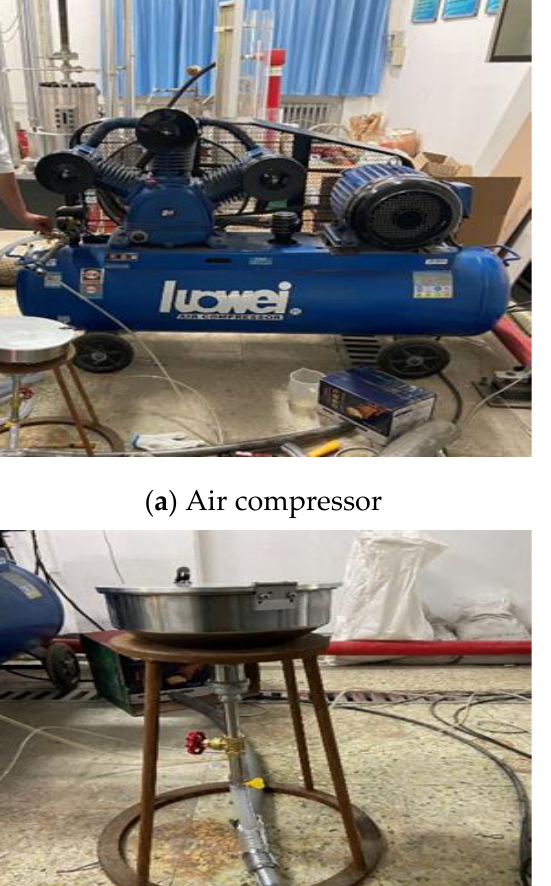
Figure 2. Photos of the experimental device.